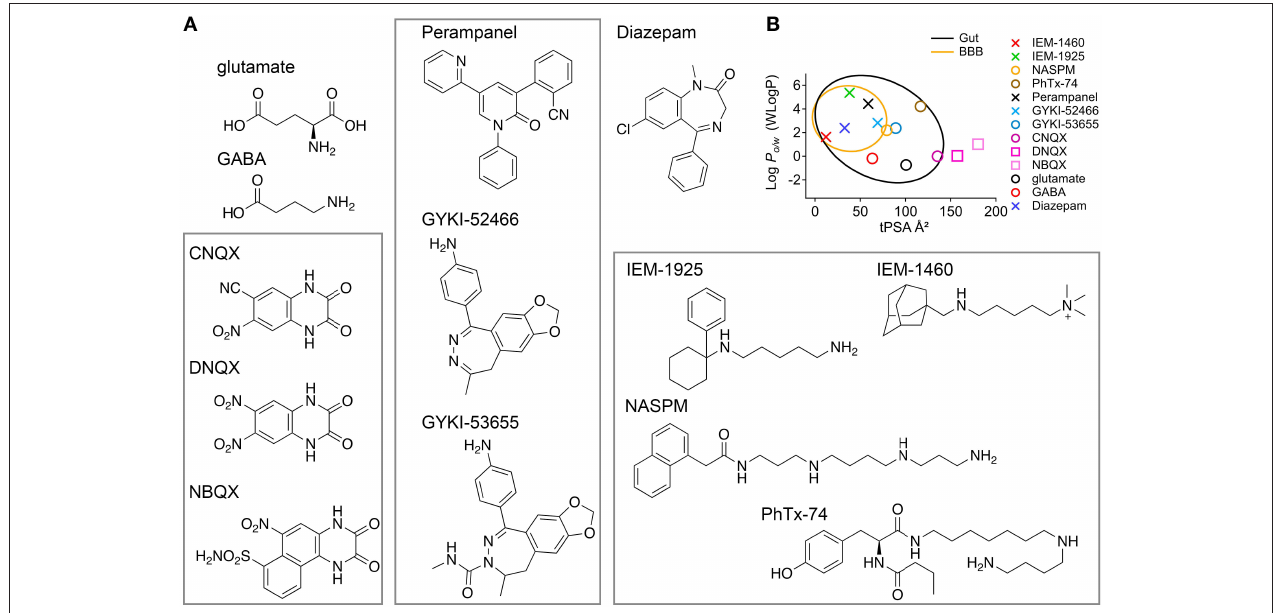
FIGURE 7 | Molecular structures and CNS accessibilities of AMPAR antagonists (rectangles). (A) The agonists glutamate and GABA are small but not very lipophilic. CNQX, DNQX, and NBQX are competitive AMPAR antagonists likely too polar to pass the gut. Perampanel, GYKI-52466, and GYKI-53655 are non-competitive and non-selective AMPAR antagonists that function as negative allosteric modulators. IEM-1460, IEM-1925, NASPM, and PhTx-74 are non-competitive and selective CP-AMPAR antagonists that function as open-channel pore blockers. (B) The so-called “boiled egg plot” uses a hydrophilicity metric developed by Wildman and Crippen (Y-axis, WLogP) and topological polar surface area (X-axis, tPSA) to predict gastrointestinal absorption and brain penetration. Egg-white region: high probability of absorption by the gastrointestinal tract; Egg-yolk region: highest probability of permeation through the blood-brain barrier (BBB). The drugs Perampanel and Diazepam are well within the egg yolk. Glutamate and GABA, although made in the brain, are predicted not to penetrate the BBB. IEM-1460 and IEM-1925 are less potent than NASPM and PhTx-74 ( µ M vs. nM potency) but more likely to permeate the CNS.